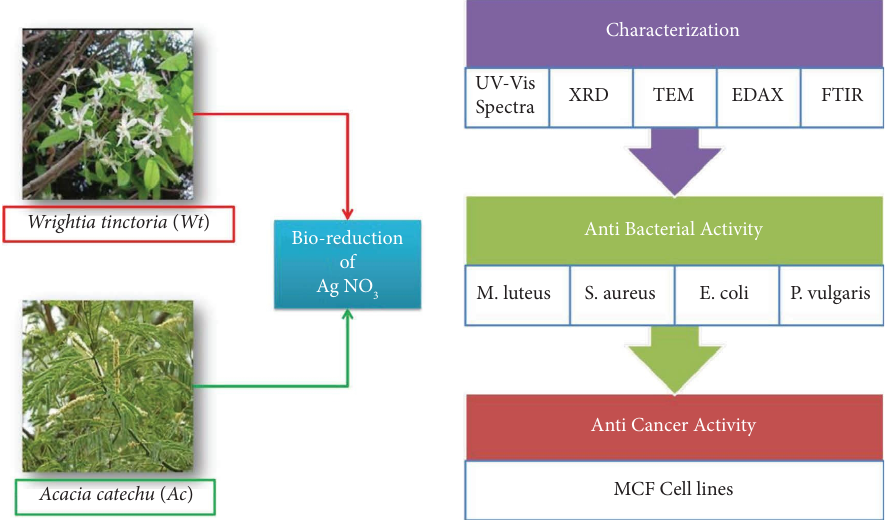
Figure 1: Schematic representation of the present